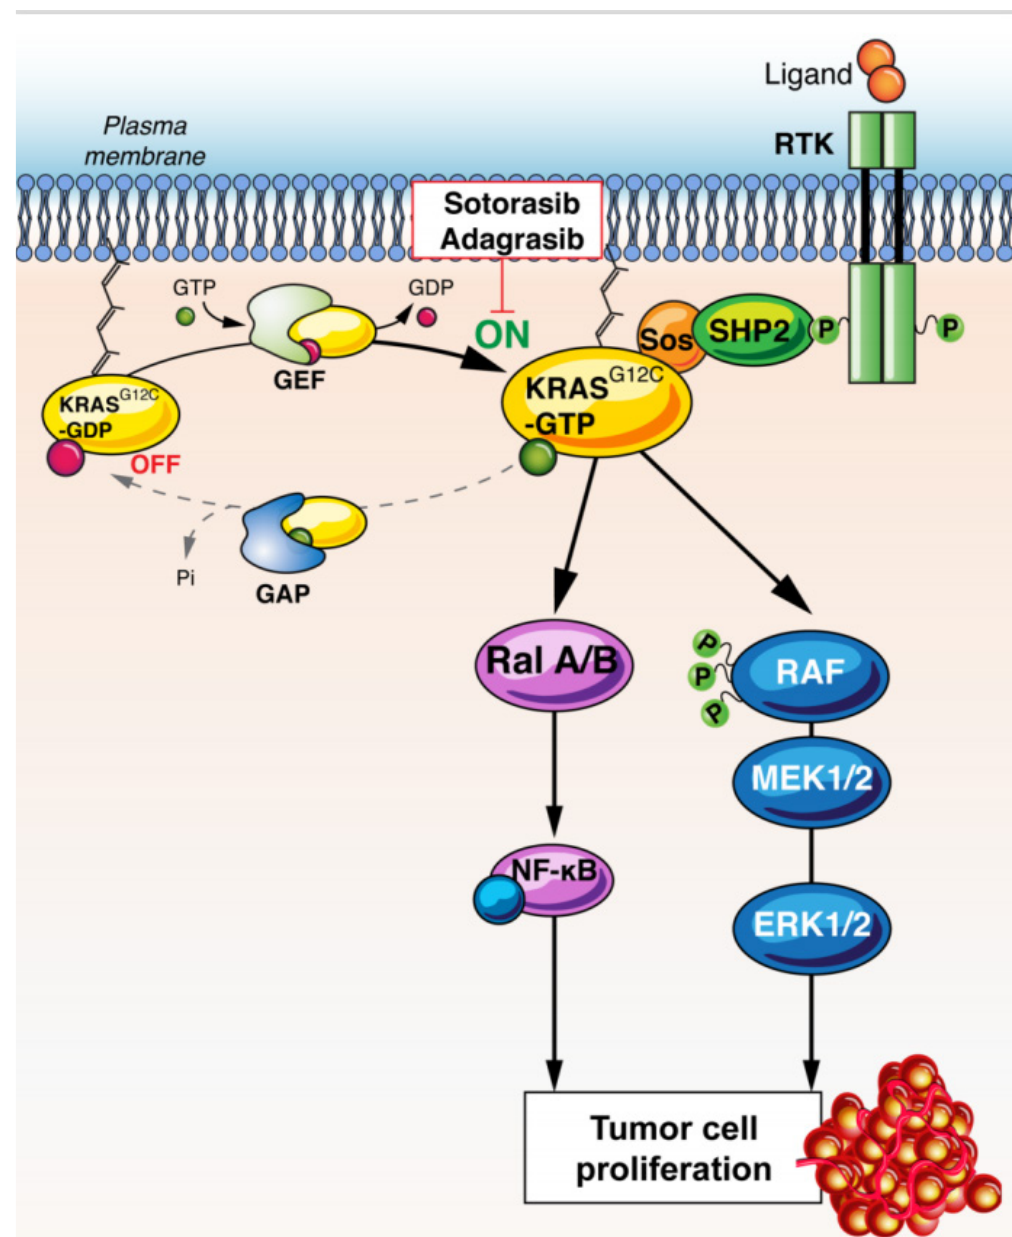
Figure 1. Mechanism of action of G12C inhibition. KRAS G12C signaling preferentially activates downstream Ral A/B and RAF/MEK/ERK pathways. KRAS inhibitors block these pathways, inhibiting cell proliferation. Abbreviations: RTK: receptor tyrosine-kinase, KRAS: Kirsten rat sarcoma, GAP: GTPase activating proteins, GEF: guanine nucleotide exchange factors, SOS: son of sevenless, SHP2: Src homology region 2 domain-containing phosphatase-2, Ral: Ras-like, NF-kB: nuclear factor-kB, RAF: RAF proto-oncogene serine/threonine-protein kinase, MEK: Mitogen-activated protein kinase kinase, ERK: extracellular signal-regulated kinase.